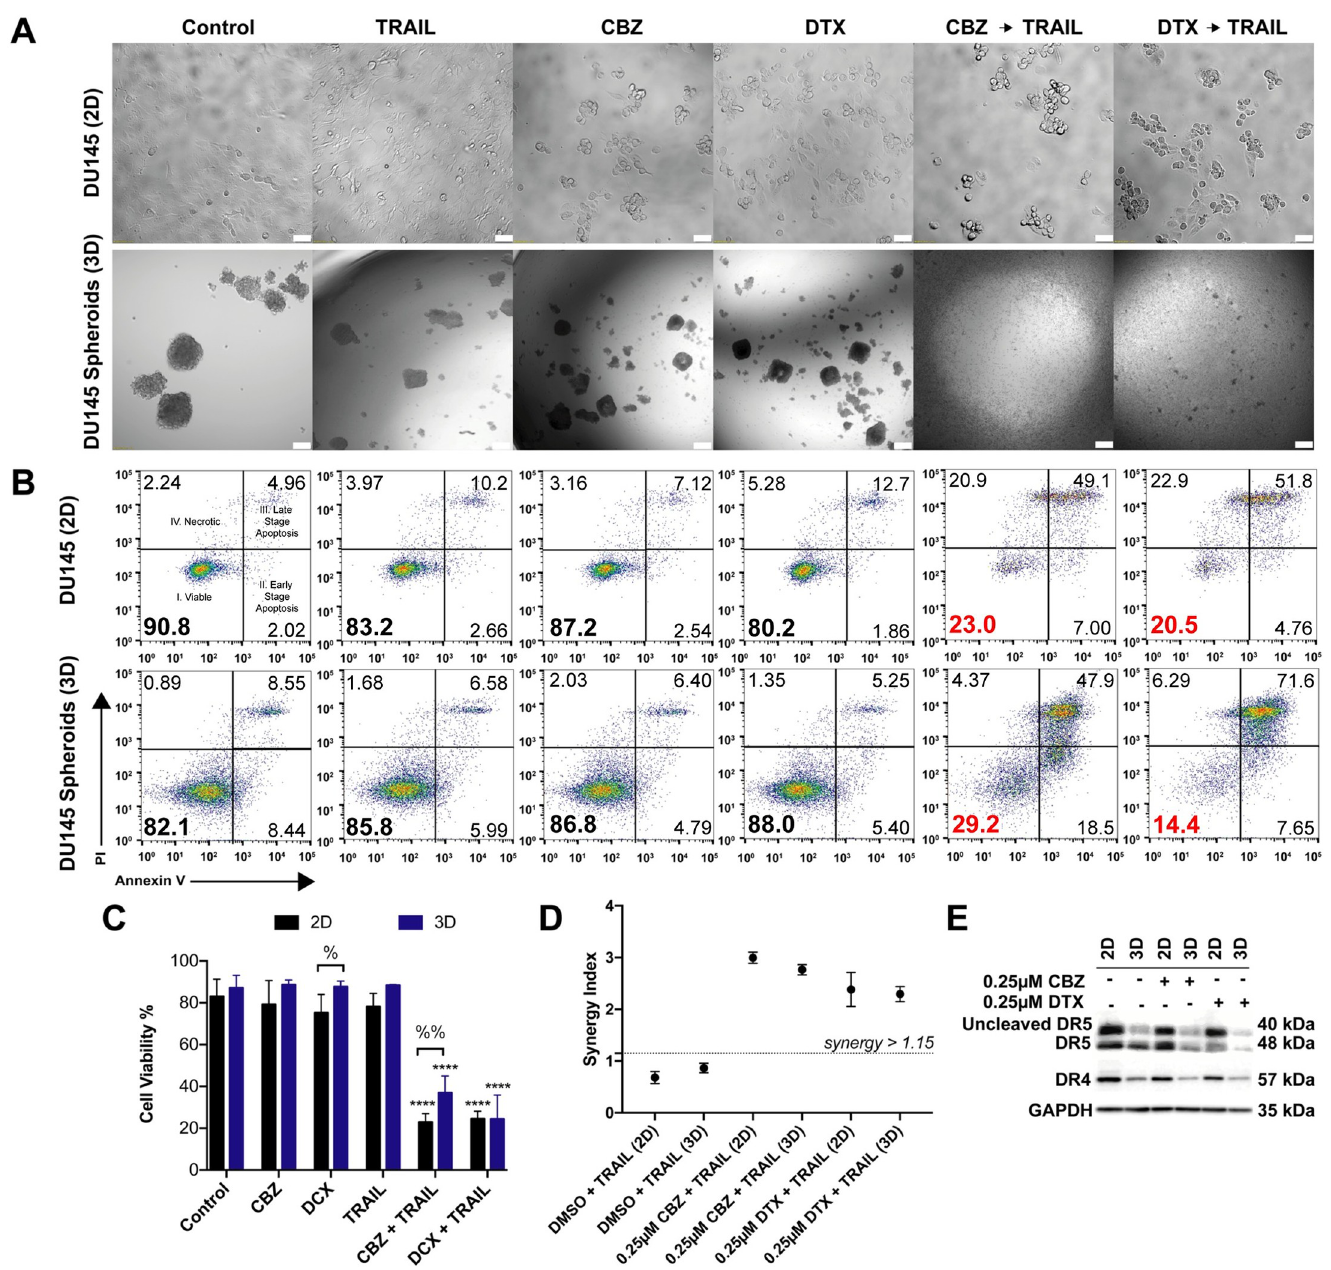
Fig 5. DU145 spheroids have a lower expression of death receptors but equal sensitivity to taxane plus TRAIL combination therapy. A . Brightfield images of DU145 cells cultures as 2D monolayer and 3D spheroids after 24 hr treatment exposure with DMSO, TRAIL, CBZ, DTX, CBZ + TRAIL, DTX + TRAIL. Scale bar = 50 μ m (top row) and 100 μ m (bottom row). B . Representative flow cytometry plots of 2D and 3D DU145 cells indicating apoptosis based on treatment conditions. C . Annexin-V/PI assay results quantifying viability of 2D and 3D DU145 cells under different treatment conditions (n = 6). D . Graph displaying synergistic anti-tumor effect of combined taxane and TRAIL in DU145 cells by Jin’s formula (n = 3). E . Western blot of death receptor expression in 2D and 3D DU145 cells treated with DMSO, CBZ or DTX. The values represent the mean ± SD. ���� p � 0.0001, significantly different from control, % p < 0.05, %% p � 0.01, significantly different 2D vs 3D